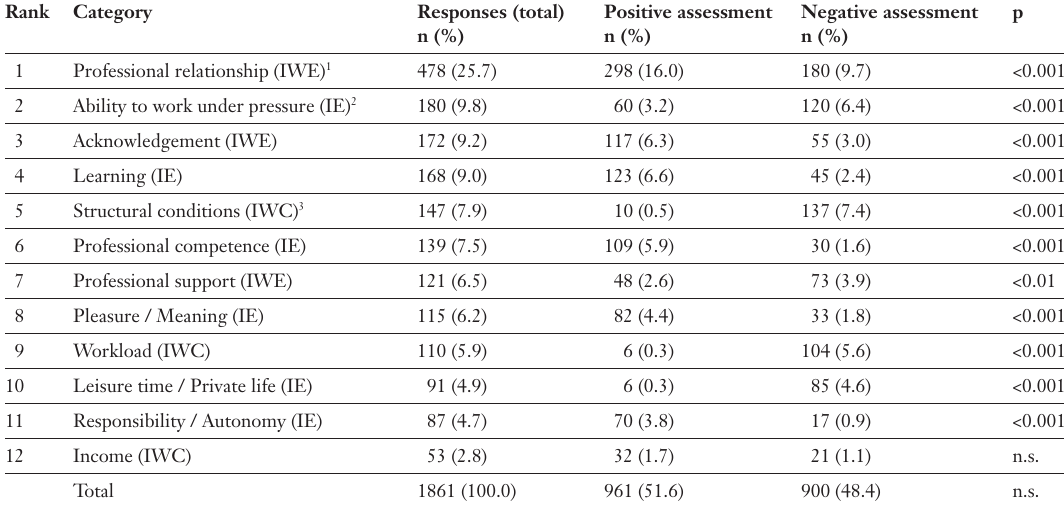
Table 1 Ranking and fre- quency distribution of residents’ responses (n = 1861) concerning positive and negative assess- ments of career- entry experiences by 342 residents.